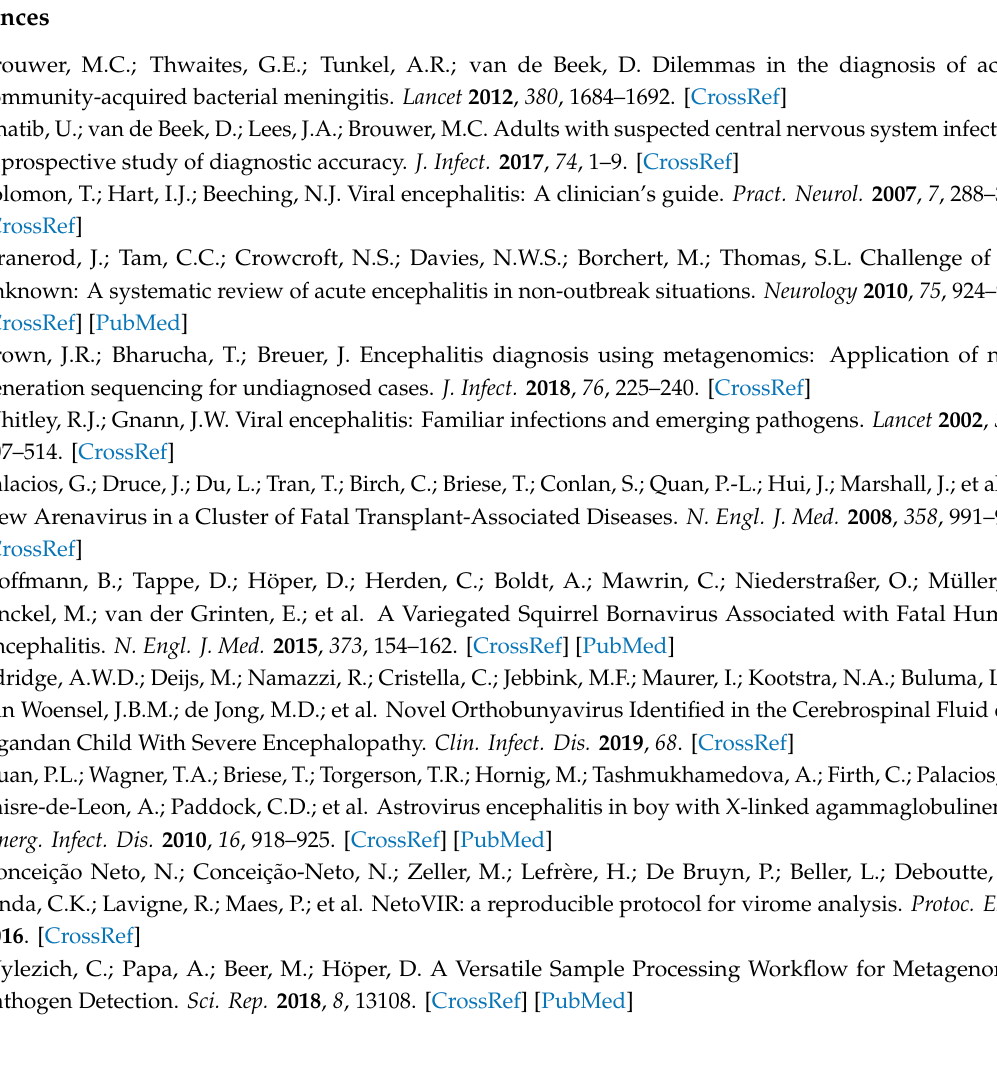
Table S1: VIDISCA-NGS and qPCR data for all